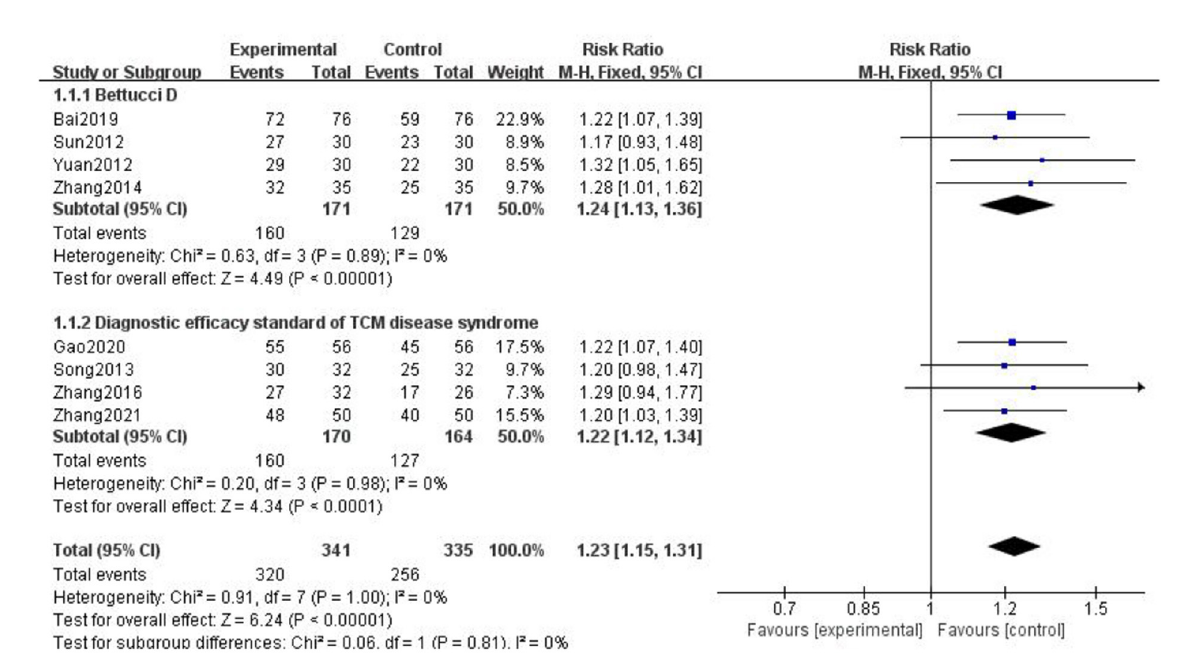
FIGURE5 Forest chart of clinical trial efficacy divided into subgroups according to evaluation criterion.